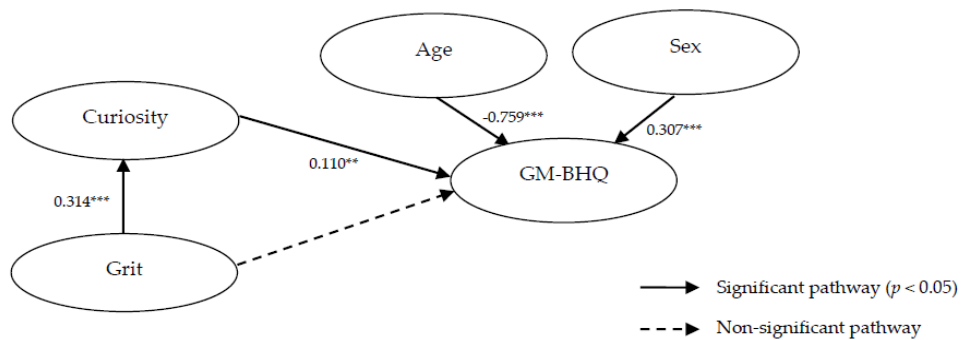
Figure 2. Path diagram for the resulting association between psychological scales and the GM-BHQ. Goodness-of-fit indices: χ 2 = 5.874; df = 5; root mean square error of approximation (RMSEA) = 0.030; probability of close fit (PCLOSE) = 0.576; goodness of fit index (GFI) = 0.989; adjusted goodness of fit index (AGFI) = 0.966; normed fit index (NFI) = 0.978; comparative fit index (CFI) = 0.997. n = 200; ** p < 0.01; *** p < 0.001.